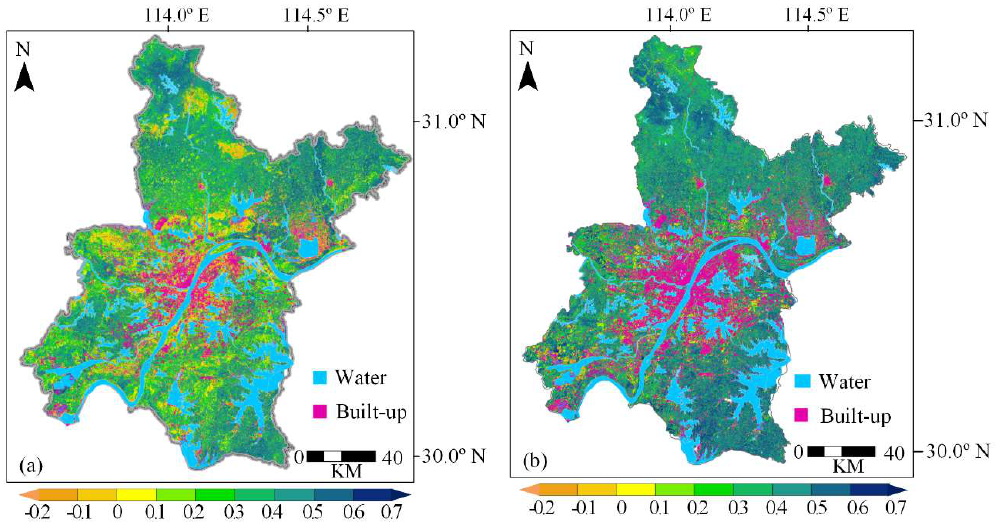
Figure 3. Urban greenness maps ( NDVI ) of the start year (2000, ( a )) and the end year (2018, ( b )).